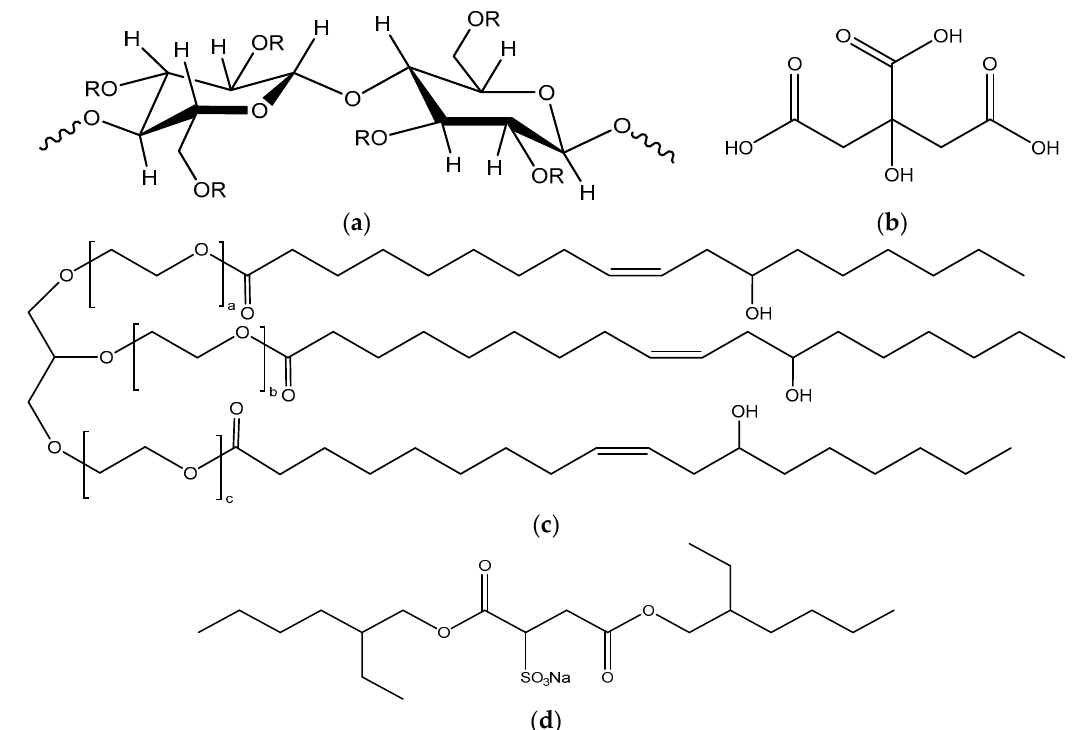
Figure 9. Schematic representation of chemical structures of ( a ) HPMC, with R = -H, -CH 3 , or -(CH 2 -CHOH-CH 3 ) n ; ( b ) citric acid; ( c ) Kolliphor ® EL, where a + b + c = 35 [30]; and ( d ) AOT.